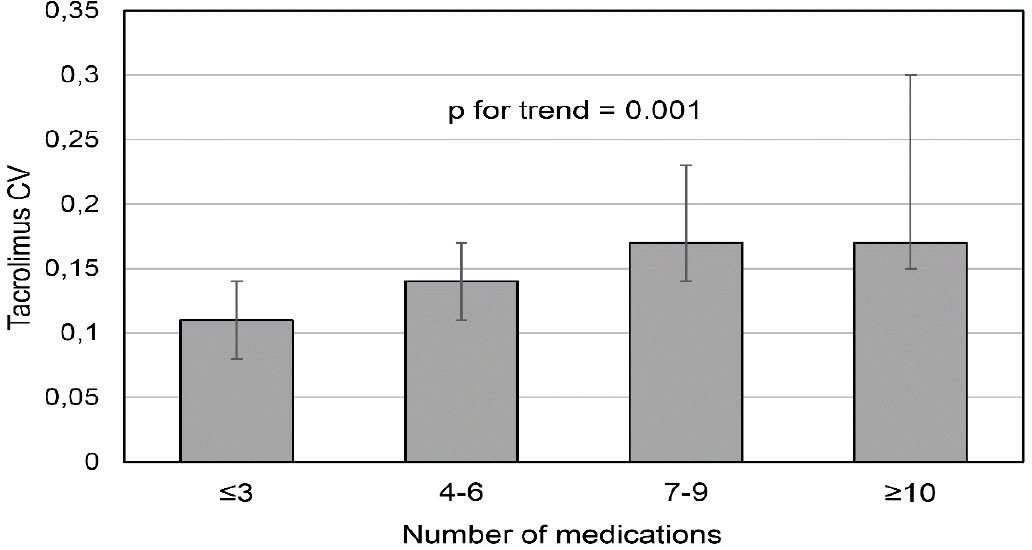
Figure 1. The variability of tacrolimus blood trough levels measured by coefficient of variation (CV) in the subsequent groups based on the increasing number of medications.